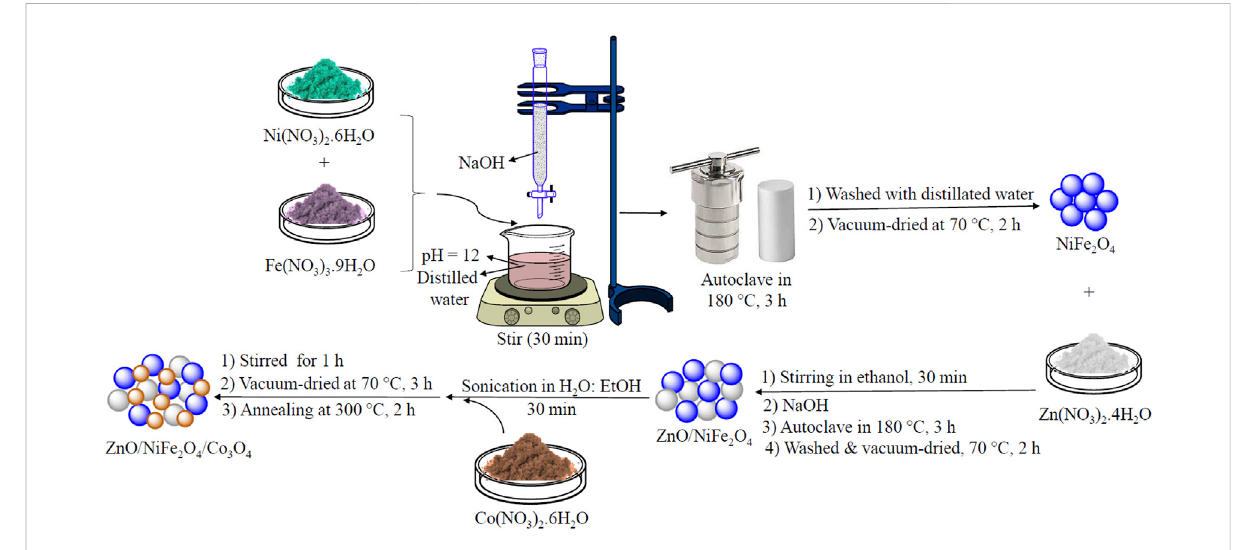
FIGURE 1 Schematic illustration of the fabrication process of the ZnO/NiFe 2 O 4 /Co 3 O 4